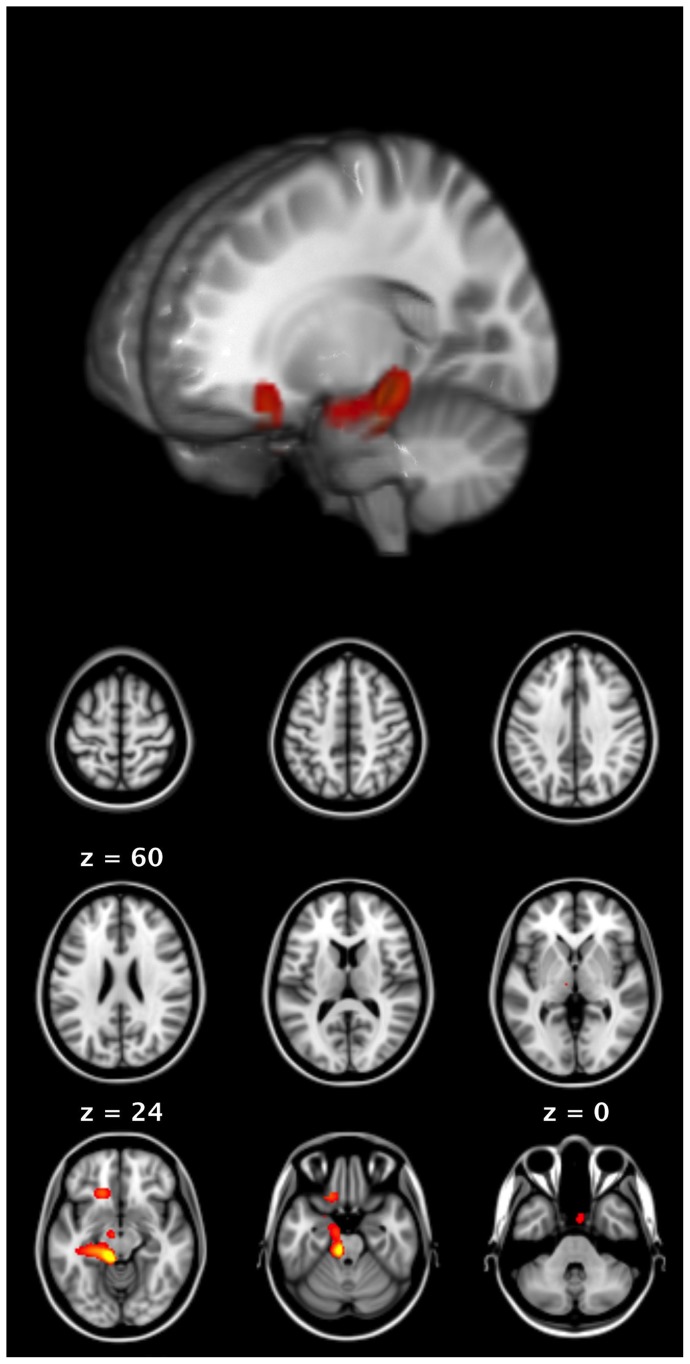
Results of beamformer analysis for gamma band time frequency window (50–90 Hz, −100 to 100 ms relative to speech onset).The ANOVA of the source images shows a main effect of condition localized to left medial temporal lobe, striatum, thalamus, and ventromedial prefrontal cortex related to meaningful trials.